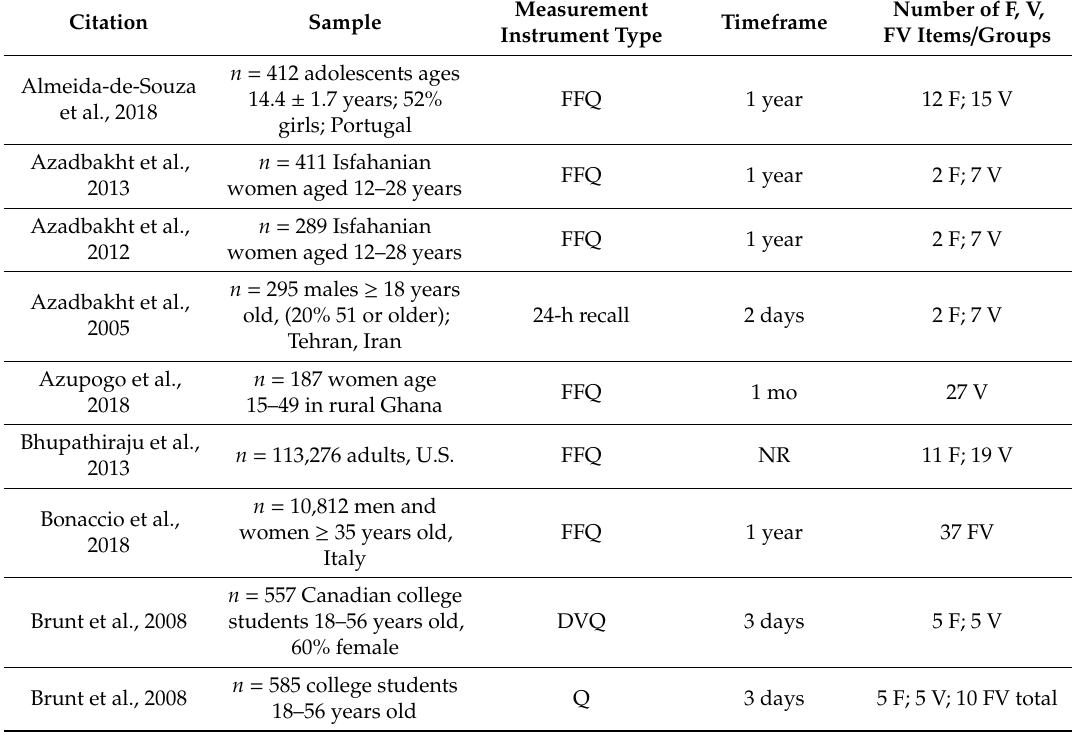
Table 2. Overview of studies meeting the inclusion